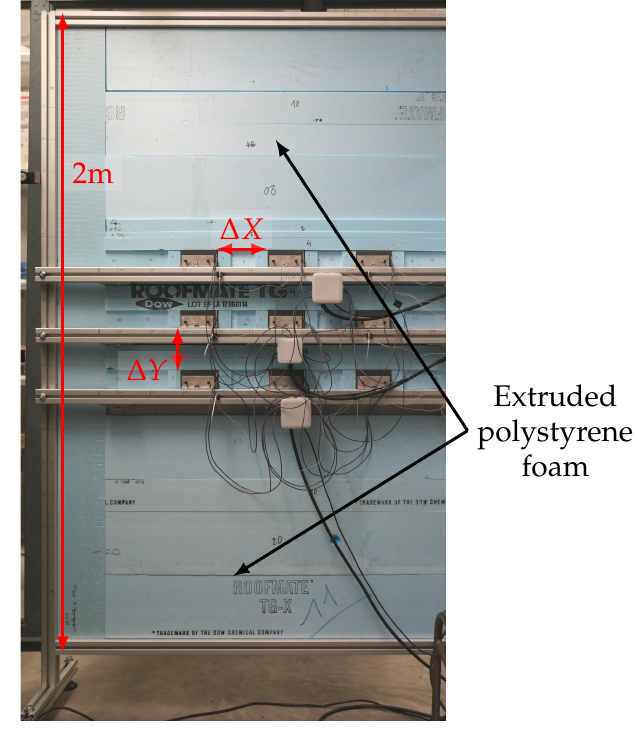
Figure 2. Experimental setup with isolating pieces and structure to change the spacing on the backside of the vertical